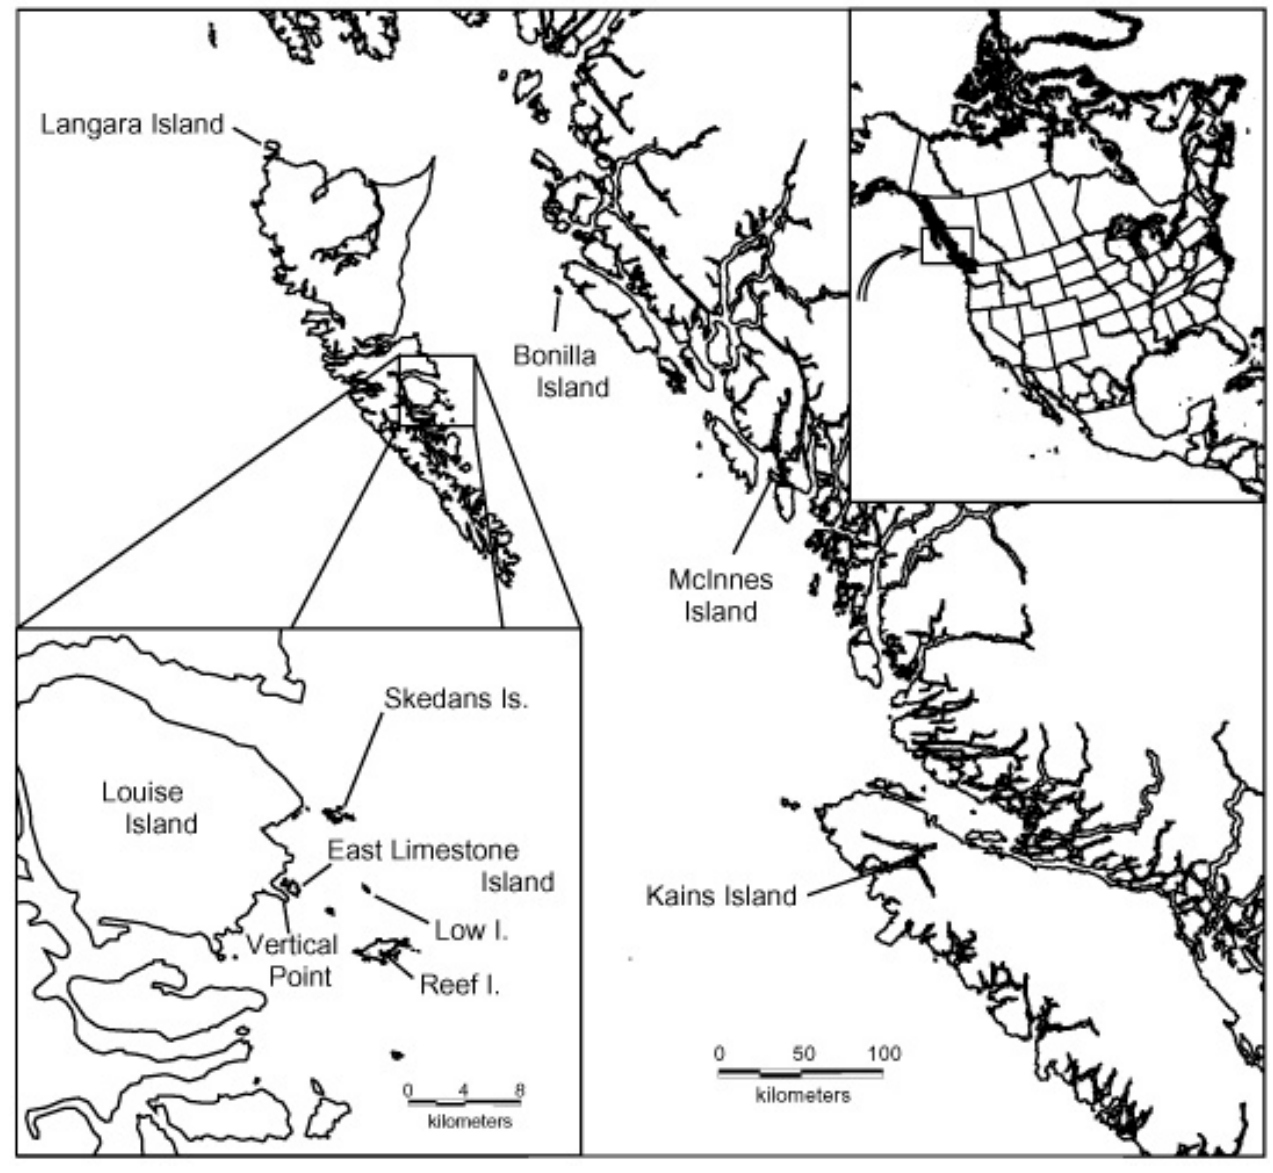
Fig. 1 . Map of Haida Gwaii and adjacent coasts showing the position of light stations providing sea surface temperatue data at Innes Point, Bonilla, Kains, and Langara islands. The inset of the study area indicates the position of mist net locations at East Limestone Island, Vertical Point, Louise Island, Reef Island (points 13 and 16), Low Island, and West Skedans